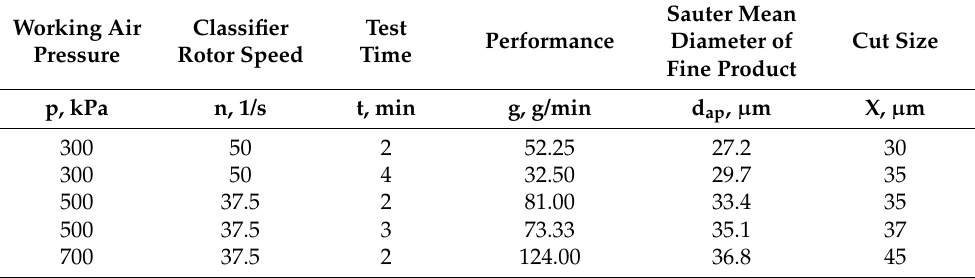
Table 3. Performance values, Sauter mean diameter of fine product and cut size for different test times, for different rotational speeds of classifier rotor, and for different pressures of working air (validation